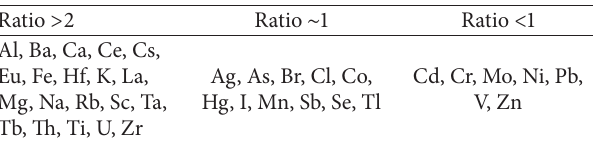
Table 4: Grouping of elements in PM winter ratio seasonal